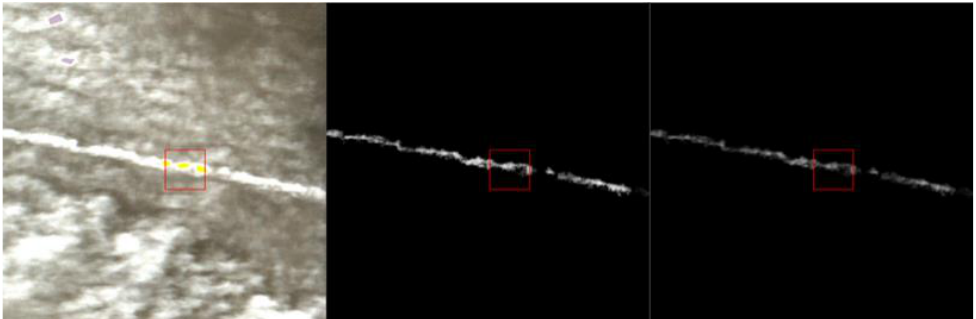
Figure 6. MF histogram stretched for AIC isolation.